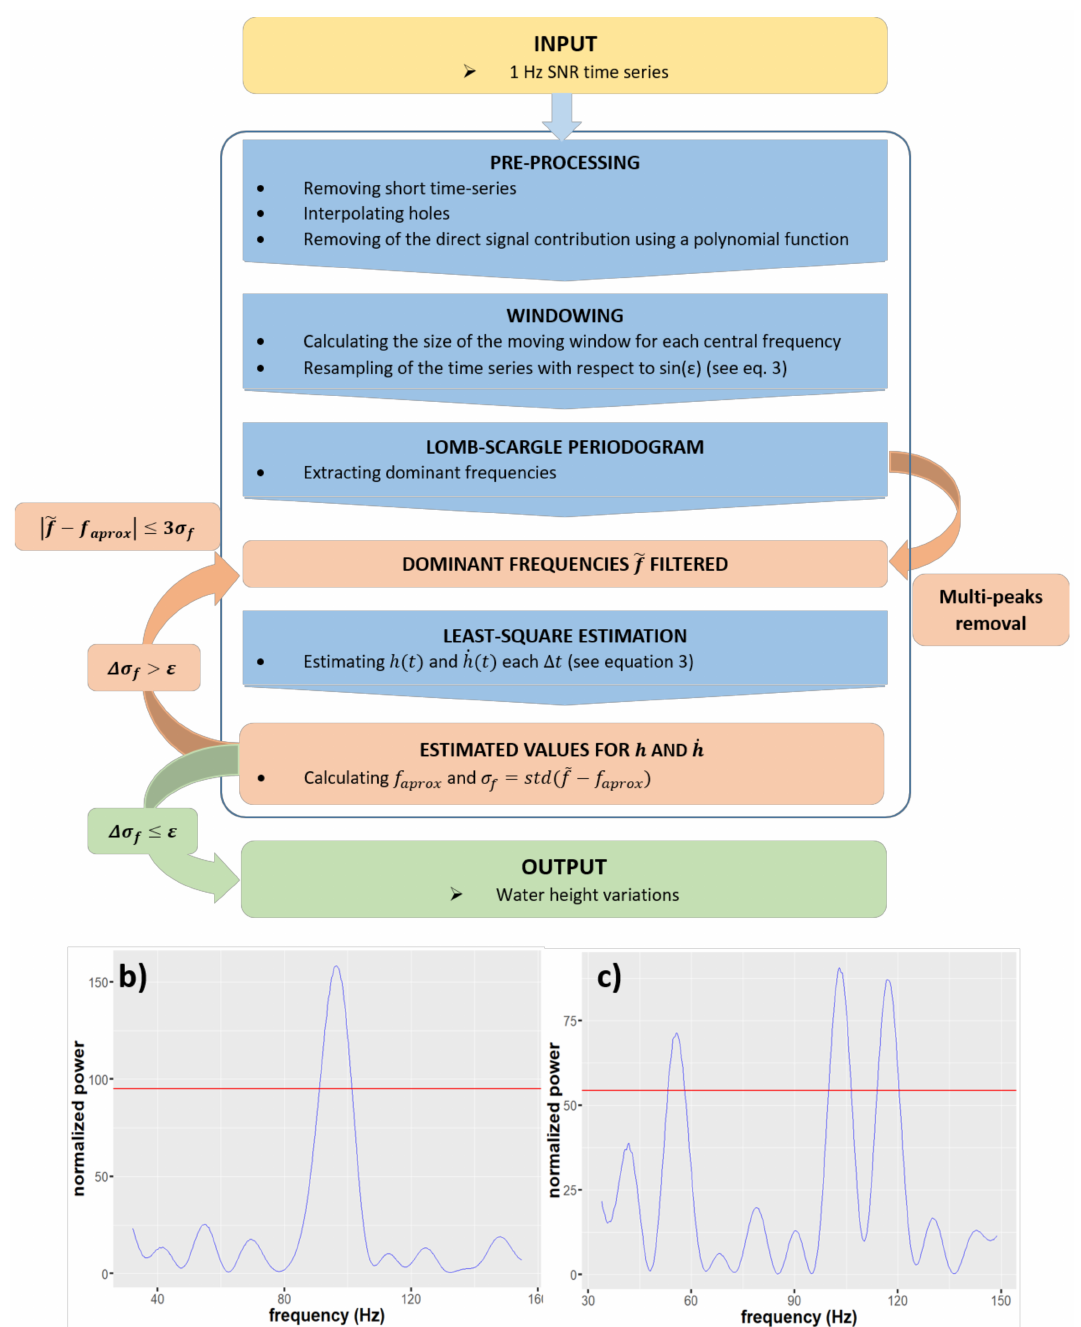
Figure 3. Flowchart of the dynamic SNR method with our improvements adapted from [29]. ( a ) Processing chain with the addition of a two-step filtering of the dominant frequencies (in orange); ( b , c ) respective examples of a single-peak output and a multipeak output from LSP for the same satellite track (G01). Red line materializes the level of filtering which depends on parameter k (here k = 0.6), and (cid:101) f ~100